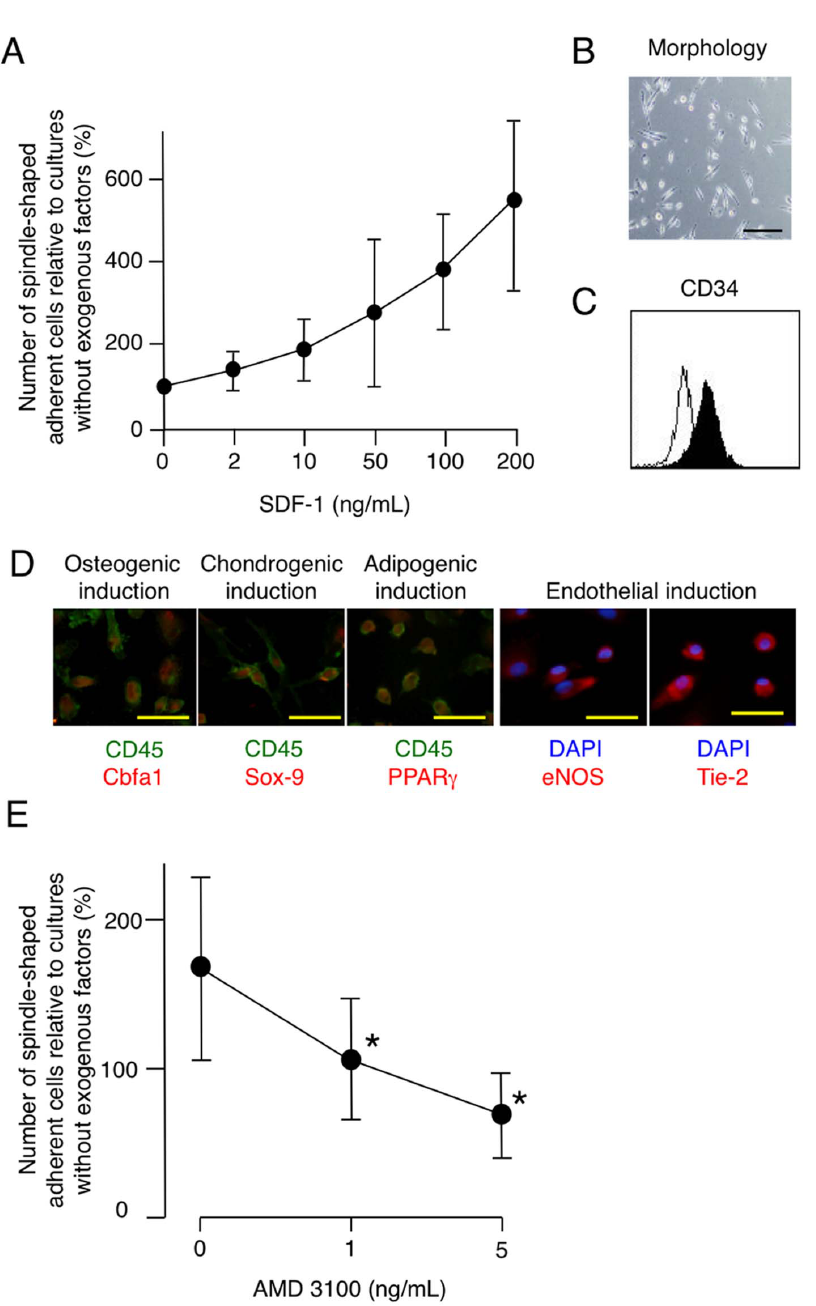
Figure 5. SDF-1 is required for generating MOMCs. CD14 + monocytes were cultured on fibronectin in the presence of serial concentrations of SDF-1. ( A ) The generation of spindle-shaped adherent cells, expressed as a proportion (%) of those generated from culturing monocytes alone. The results shown are the mean and SD of 10 independent experiments. ( B ) Morphology of adherent cells obtained in a culture with 100 ng/ml SDF-1. Bars: 200 m m. ( C ) Cell-surface CD34 expressed on adherent cells obtained in a culture with 100 ng/ml SDF-1, as analyzed by flow cytometry. Closed histograms indicate CD34 expression; open histograms represent staining with isotype-matched control mAb. ( D ) Multidifferentiation potential of adherent cells obtained in a culture with 100 ng/ml SDF-1. Cells treated for osteogenic, chondrogenic, adipogenic, and endothelial induction for 1 week were analyzed by immunohistochemical staining for Cbfa1, Sox-9, or PPAR c (red) in combination with CD45 (green), or for eNOS or Tie-2 (red) in combination with DAPI (blue), and were observed under a fluorescence microscope. Representative results of 3 independent experiments are shown. Bars: 50 m m. ( E ) AMD 3100, a CXCR4 antagonist, suppressed the generation of MOMCs. Circulating monocytes were cultured with platelet- conditioned medium on fibronectin in the presence of 0, 1, or 5 ng/ml AMD 3100. Results are expressed as a proportion (%) of the number of spindle- shaped adherent cells obtained in the culture of monocytes alone. * P , 0.05, compared with culturing without AMD 3100.